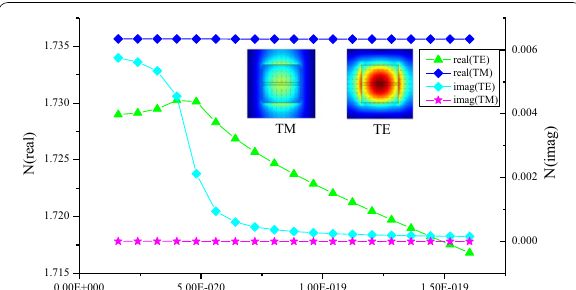
Fig. 2 Illustration of the polarization-independent electro-absorption optical modulator. a 3D Schematic diagram of the modulator; b 2D cross section of the U-structure Ge 23 Sb 7 S 70 -graphene waveguide, distance between two graphene layer d 50 nm, waveguide width = w 0.96 μm, height h 0.8 μm. The electric field distribution for = = TE mode ( c ) and TM mode ( d ), arrows indicate the direction of polarization